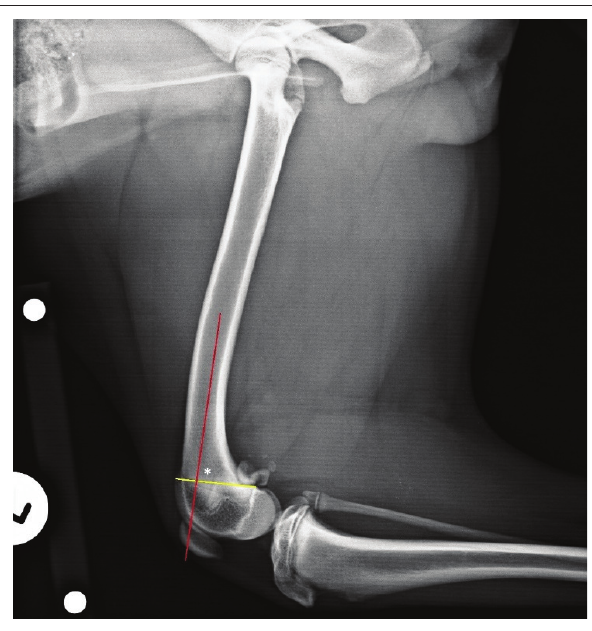
FIGURE 2: Radiographic image: Preoperative mediolateral view of the left femur. The anatomical caudal distal femoral angle ( * ) was calculated as 86° on the left.